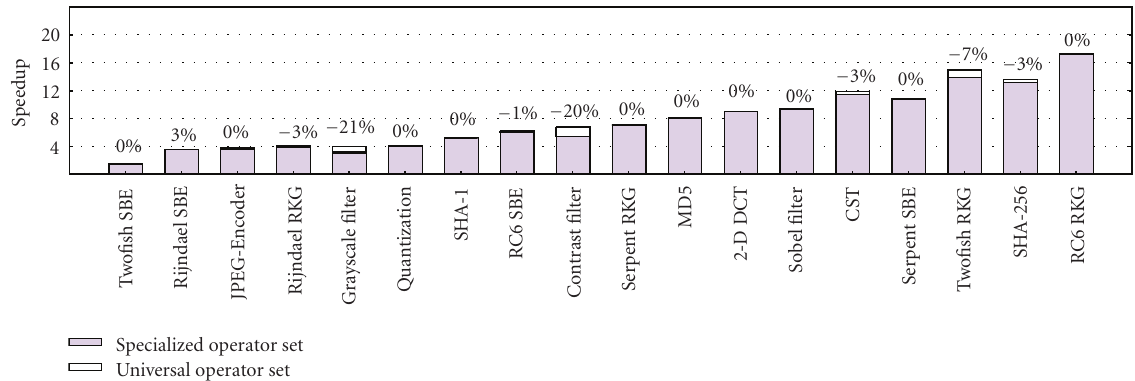
The results of the corresponding measurements